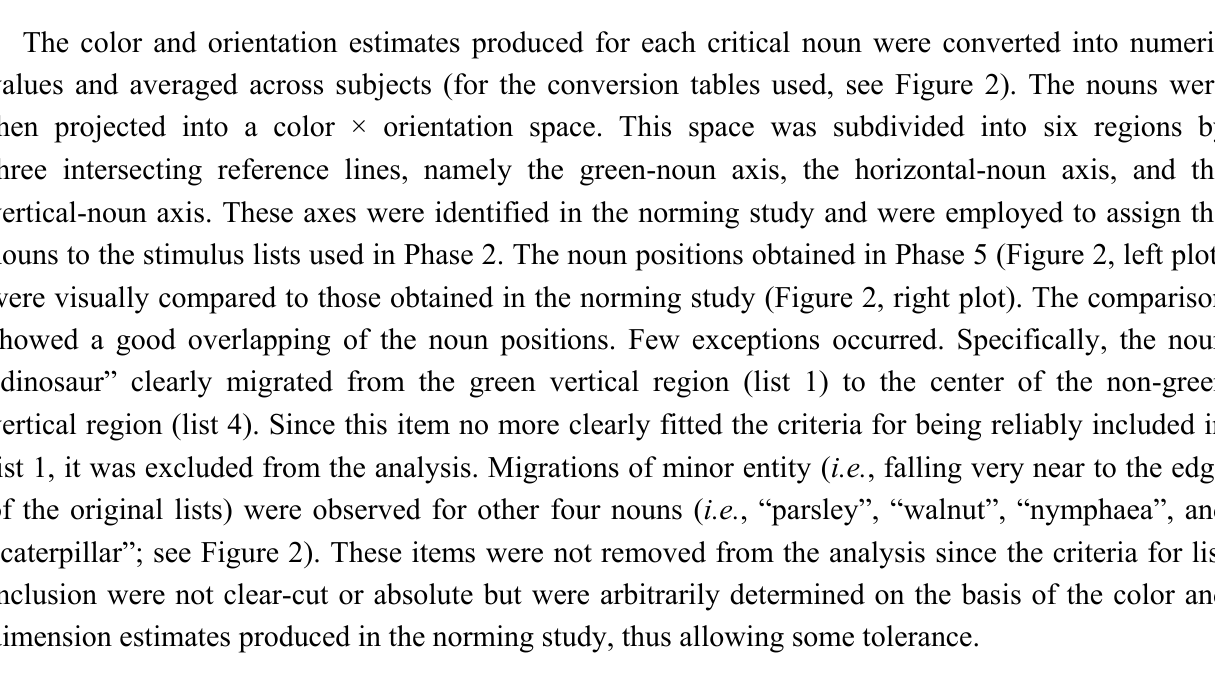
List 4: non-green vertical vs. List 5: non-green squared vs. List 6: non-green horizontal), and their mutual interaction. In order to account for more error variance, a number of covariates were also considered including lexical variables ( i.e. , word length and log-transformed written lexical